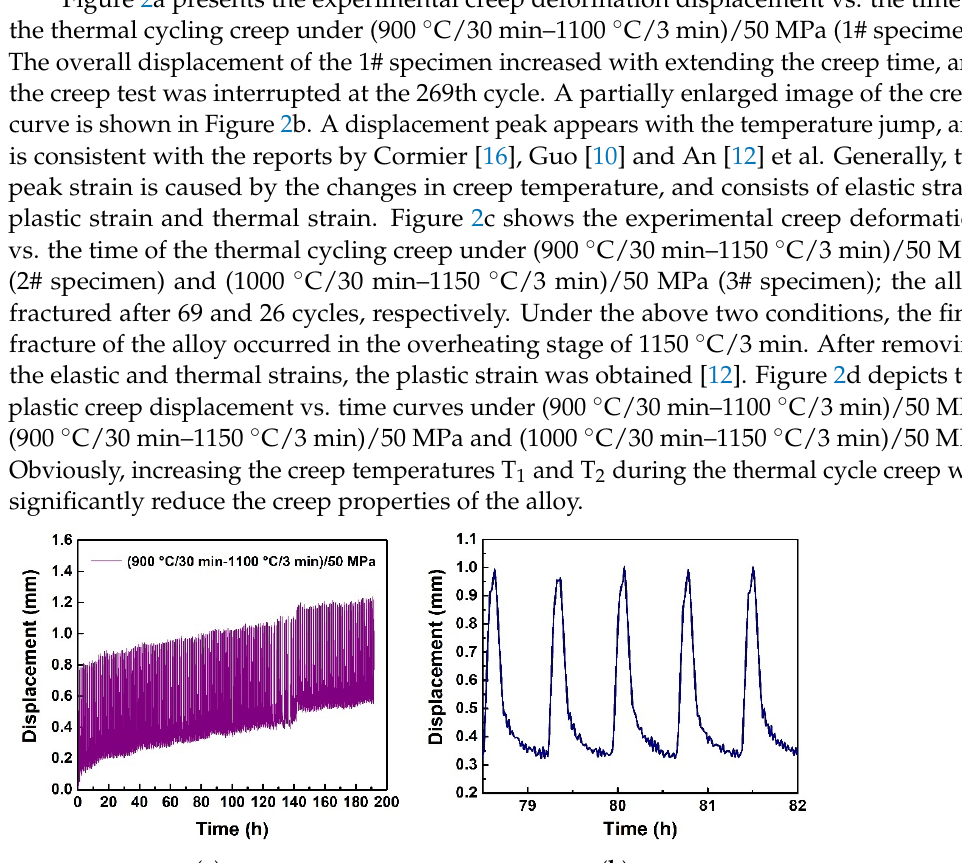
Table 1. The creep testing conditions of the thermal cycling creep of K465 superalloy. Specimen Number